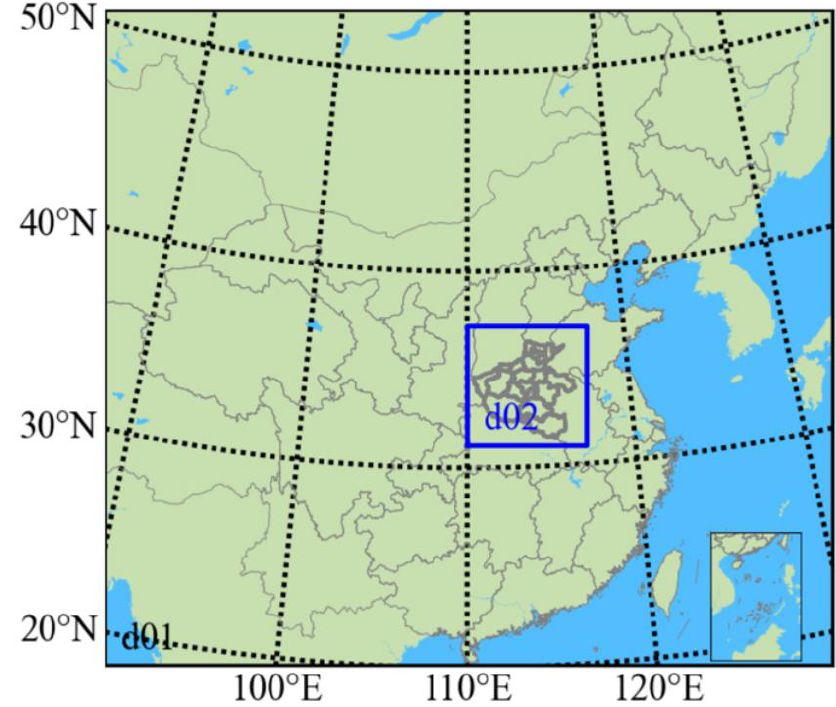
Figure 1. Location of the simulation area.